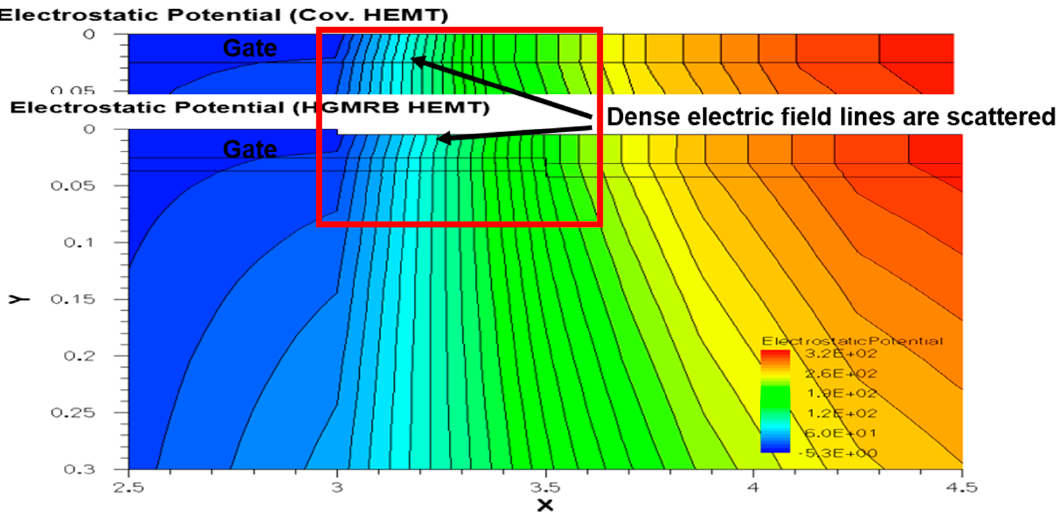
Figure 5. Electrostatic potential distribution of the conventional HEMT and proposed HGMRB HEMT.